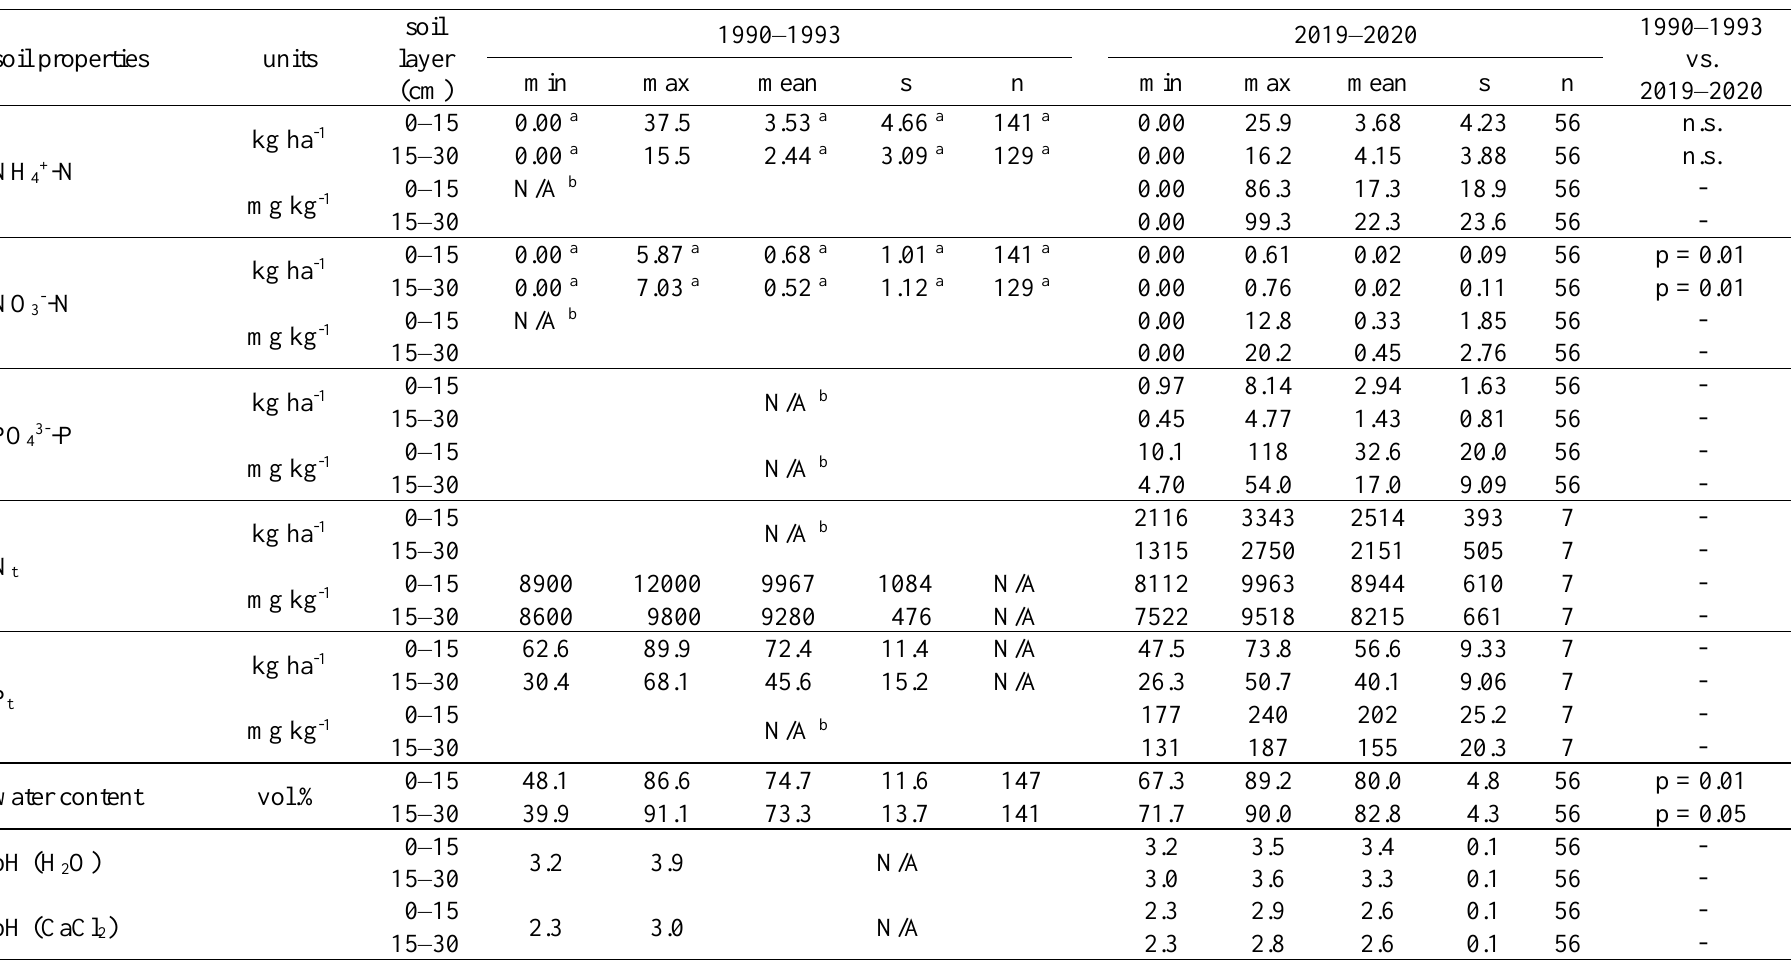
Table 1. Summary of soil properties recorded in 1990–1993 (initial examination; Gebhardt & Knabke 1994) and 2019–2020 (follow-up examination), and results of Wilcoxon signed-rank test for differences between the two examinations. min = minimum; max = maximum; s = standard deviation; n = sample size. N/A - data not available; n.s. - not significant; a - site S1 excluded because of extraordinarily high N contents during the initial examination; b - data (or unit) not provided in the initial